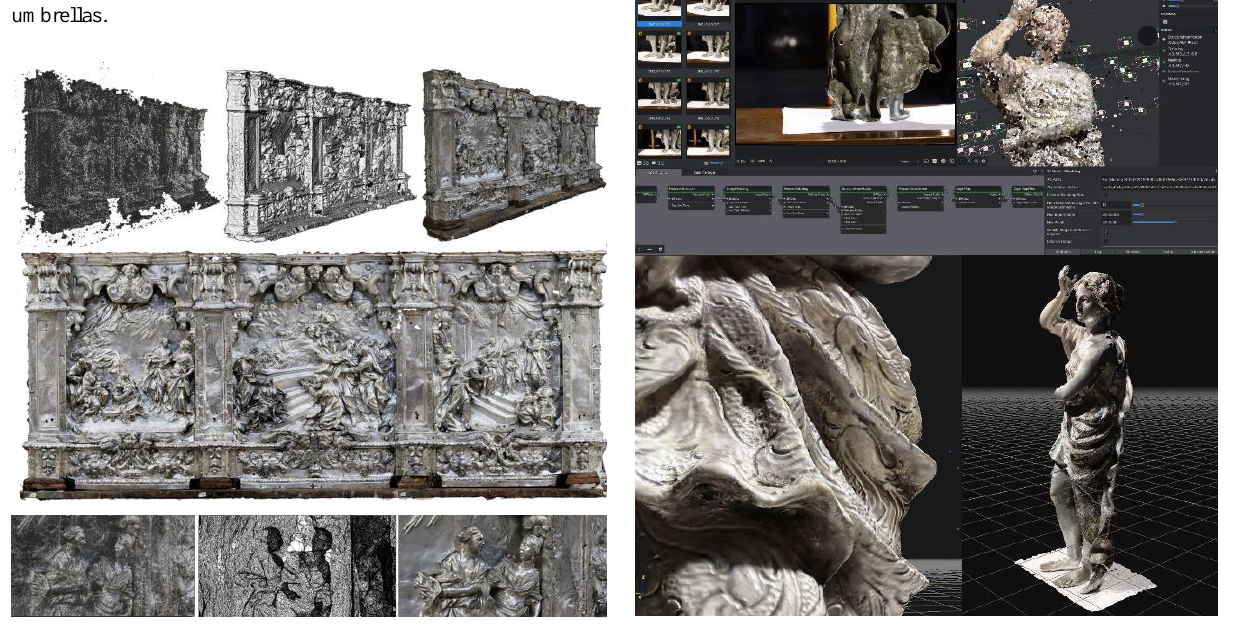
Figure 7 . VPL for SfM: caryatid